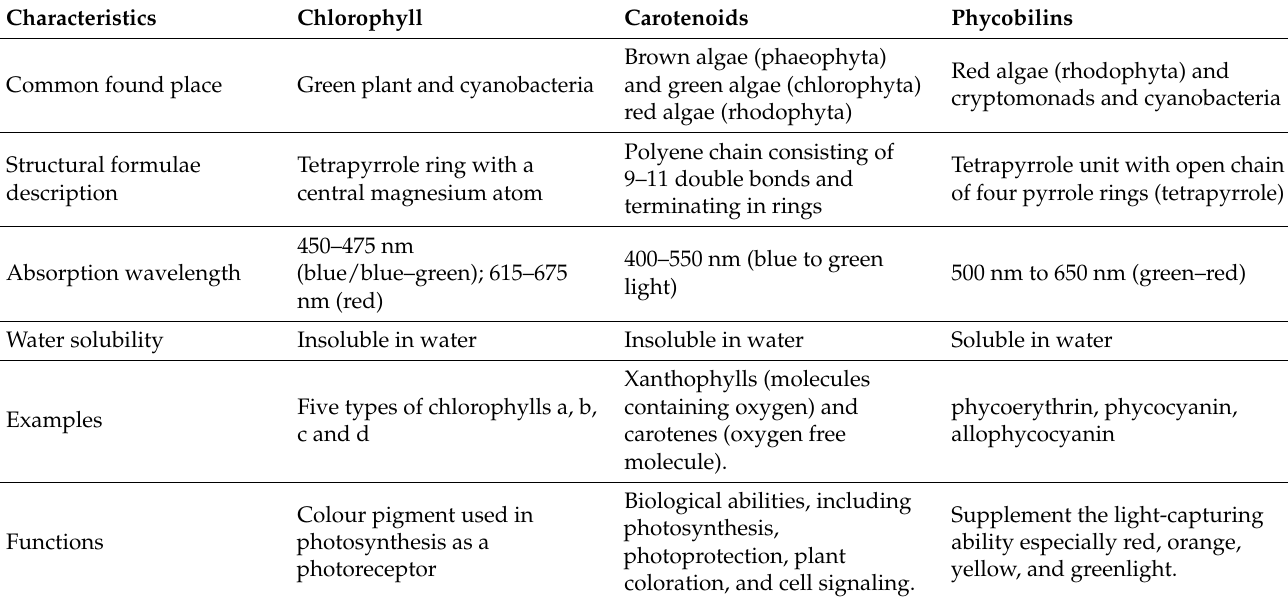
Table 2. Differences in pigment characteristics (chlorophyll, carotenoids, and